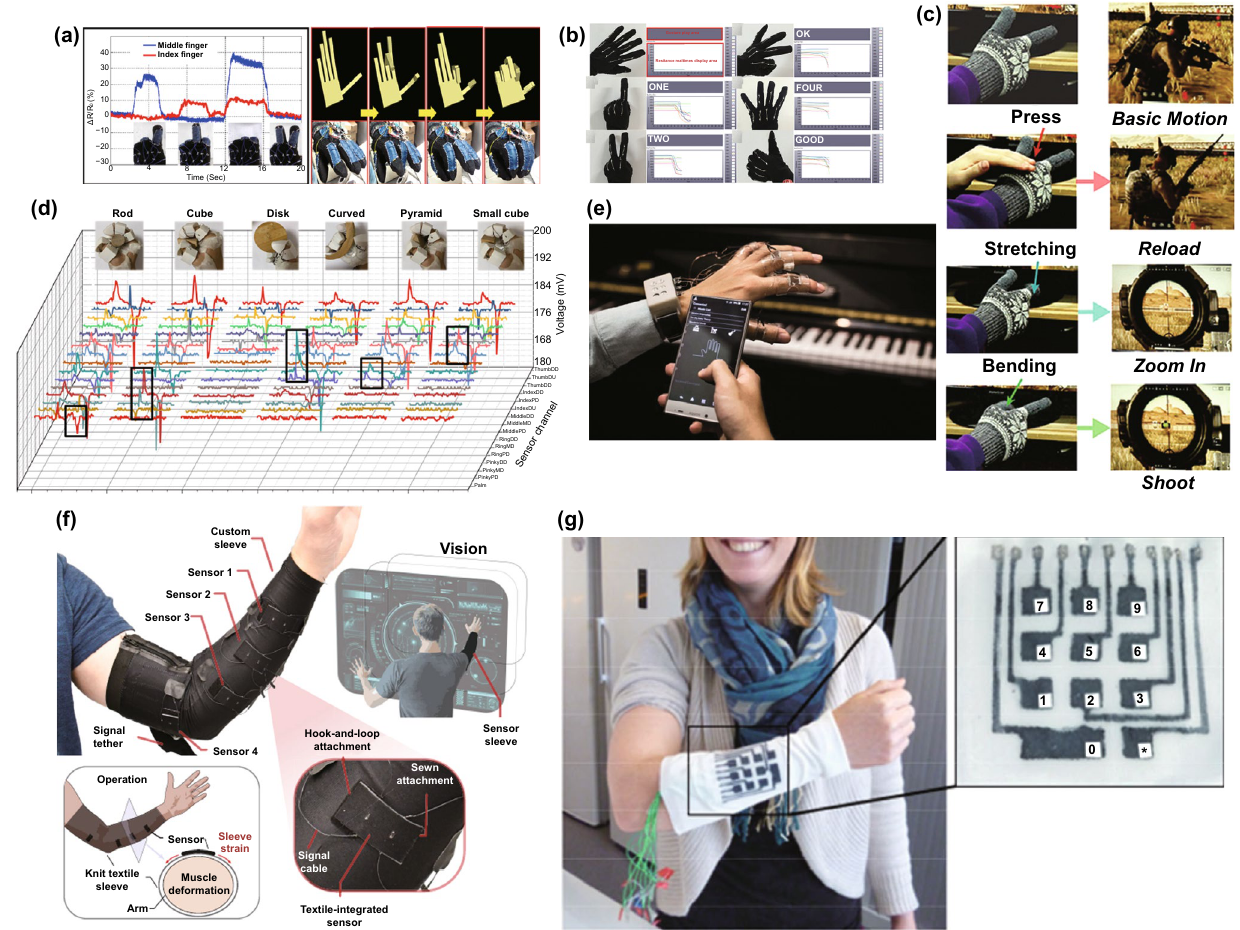
Fig. 11 a The motion detection of two different fingers (left), and the mapping of fingers motions by strain sensor gloves (right) [166]. Copy- right © 2014 American Chemical Society. b The gesture recognition by gloves with strain sensors [113]. Copyright © 2016 Wiley–VCH. c Controlling video games with smart gloves [210]. Copyright © 2019 Wiley–VCH. d Recognizing different grabbing gestures by feature outputs [211]. Copyright © 2020 American Association for the Advancement of Science (AAAS). e The optical image of the wireless instrument simu- lation system [127]. Copyright © 2017 Royal Society of Chemistry. f Photograph of a strain sensor-integrated sleeve for the future human–com- puter interfaces [212]. Copyright © 2020 Springer Nature. g The image of the fiber-based wearable keyboard [213]. Copyright © 2016